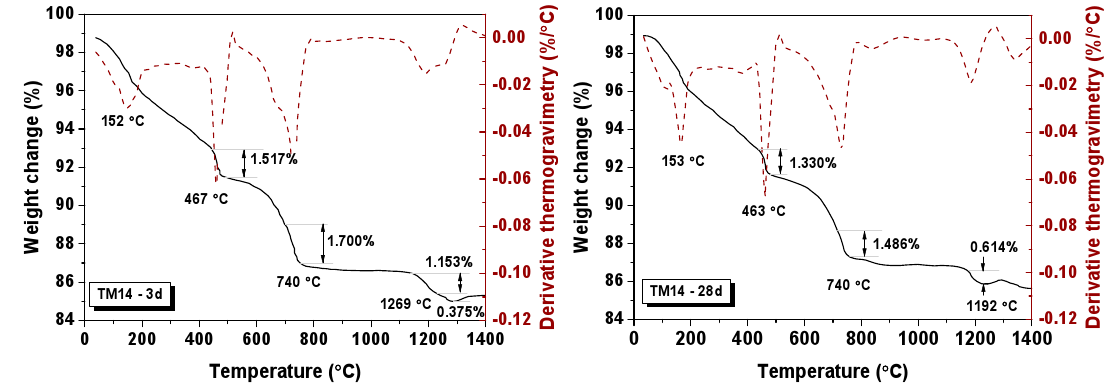
Figure 11. TGA spectra for TM14-3d and TM14-28d.